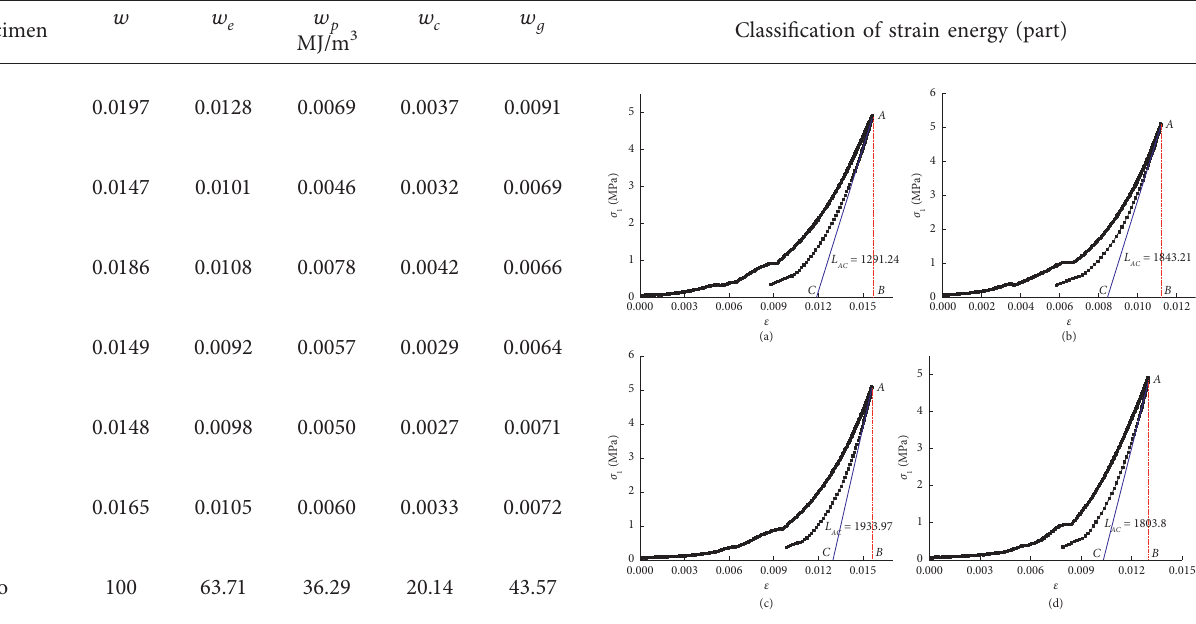
Table 1: Strain energy of coal samples from coal mine A.